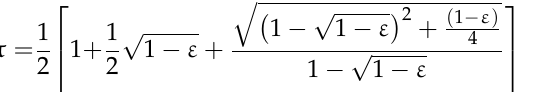
Figure 5. The calculated results are compared with the experimental data of Wang [12], Shen [29] and Hu [31].